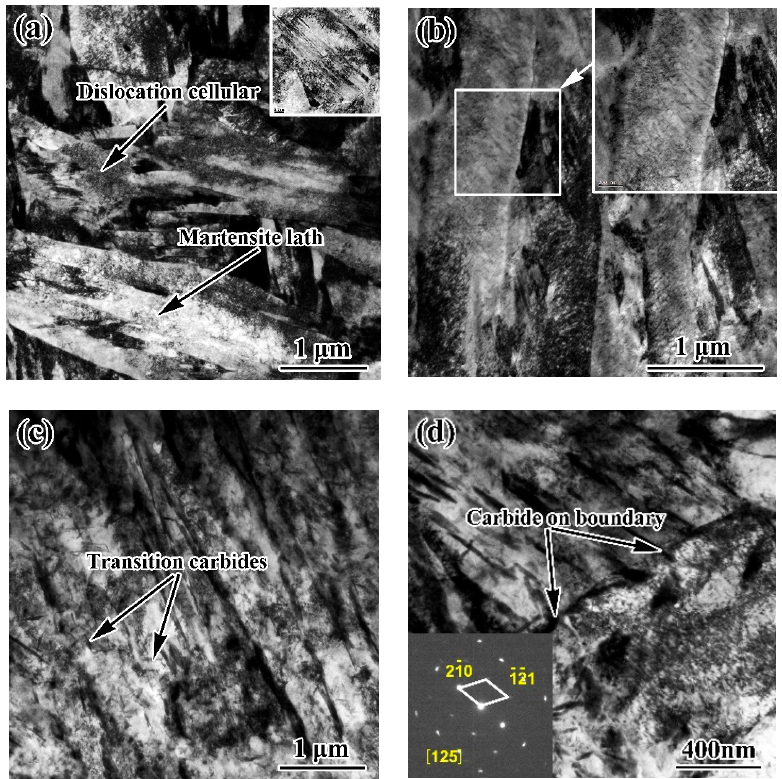
Figure 3. TEM images of the test steels tempered at different temperatures: ( a ) as-quenched; ( b ) tempered at 240 °C; ( c , d ) tempered at 400 °C.